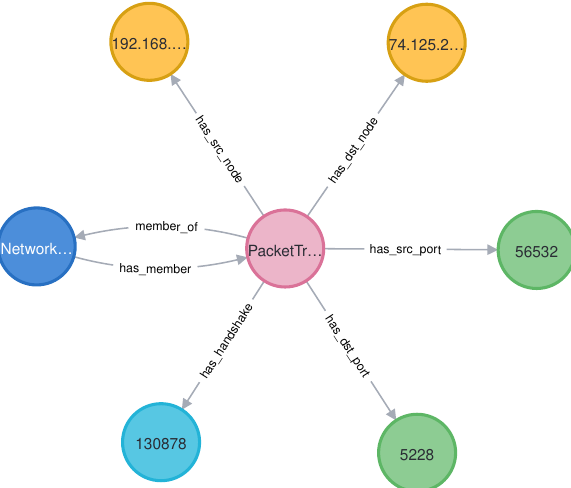
Figure 8. Visualized NTO instance generated by the Neo4j platform.